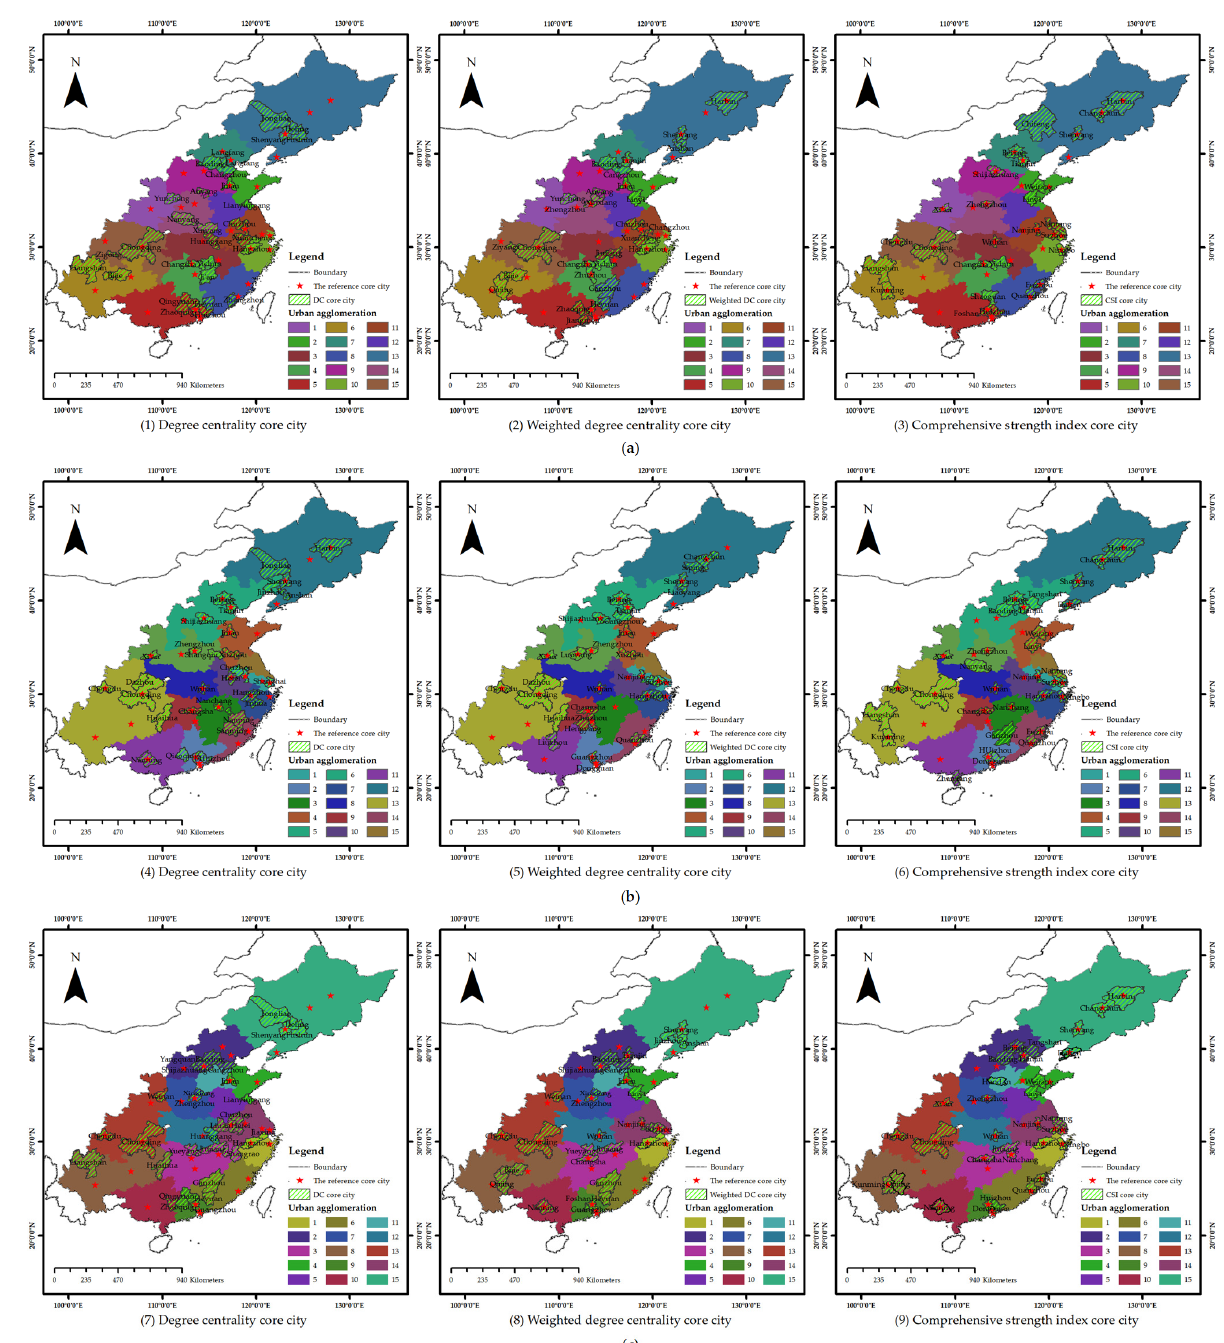
Figure 14. The core city identification results. ( a ) Nighttime light urban network; ( b ) Railway urban network; ( c ) Composite urban